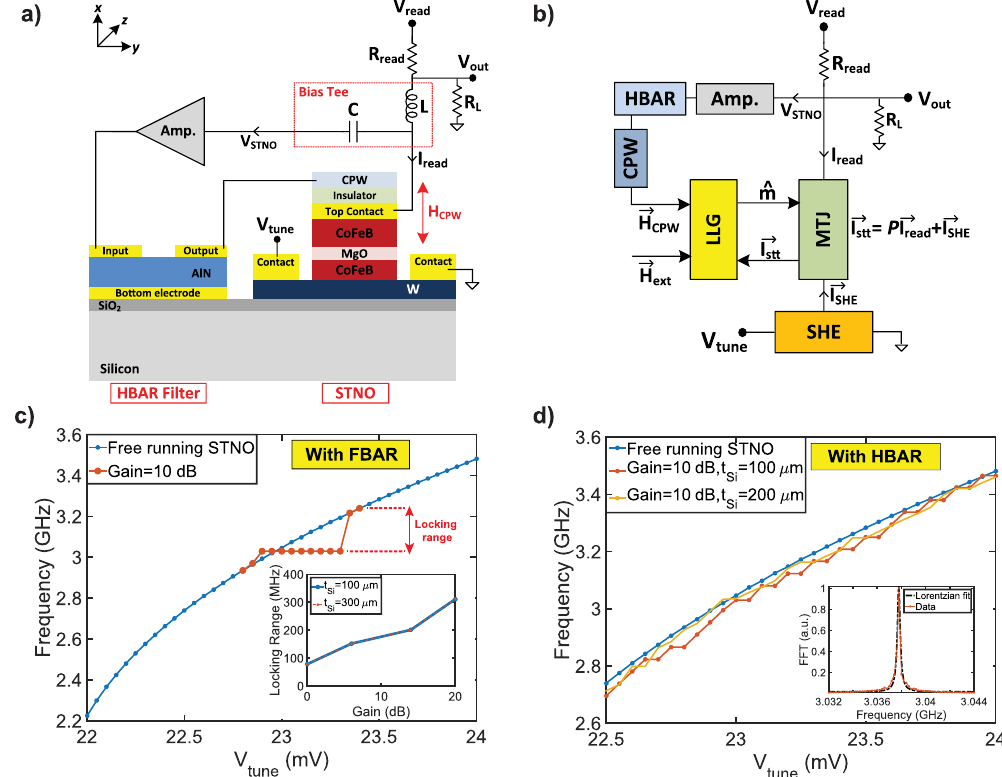
Figure 5. Implementation of MASH oscillator with magnetic field feedback: ( a ) A three-terminal MTJ with a CPW and a 2-port HBAR are fabricated on the same silicon substrate, and coupled to each other with the magnetic field. ( b ) Modular modeling of transport, magnetization, and resonator dynamics. ( c ) Locking range versus the amplifier gain for two different substrate thicknesses (100 μ m and 200 μ m). The thicker substrate ( t Si = 200 μ m) does not affect the gain needed for locking. ( d ) Tunability can be achieved with 22 MHz or 43 MHz steps depending on the substrate thickness using the same amplifier gain by locking to the nearest high Q peaks of the